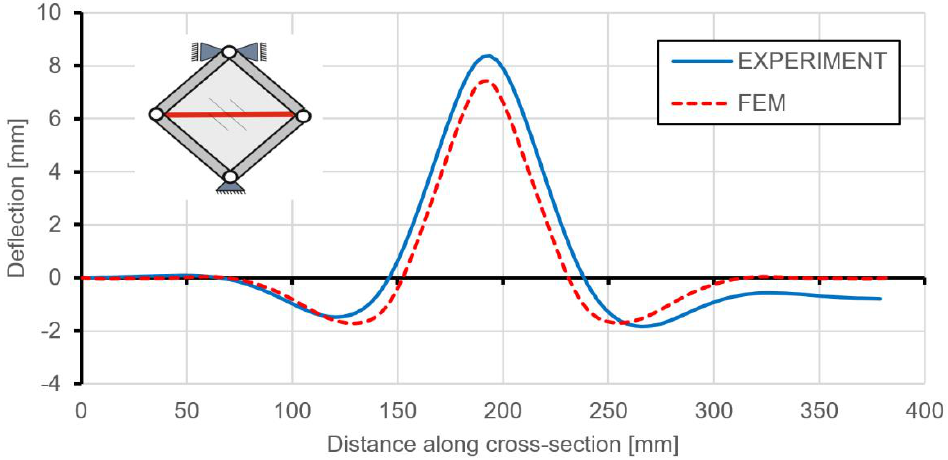
Figure 15. Deflection of a cross-section through the horizontal diagonal at the level of maximum load.